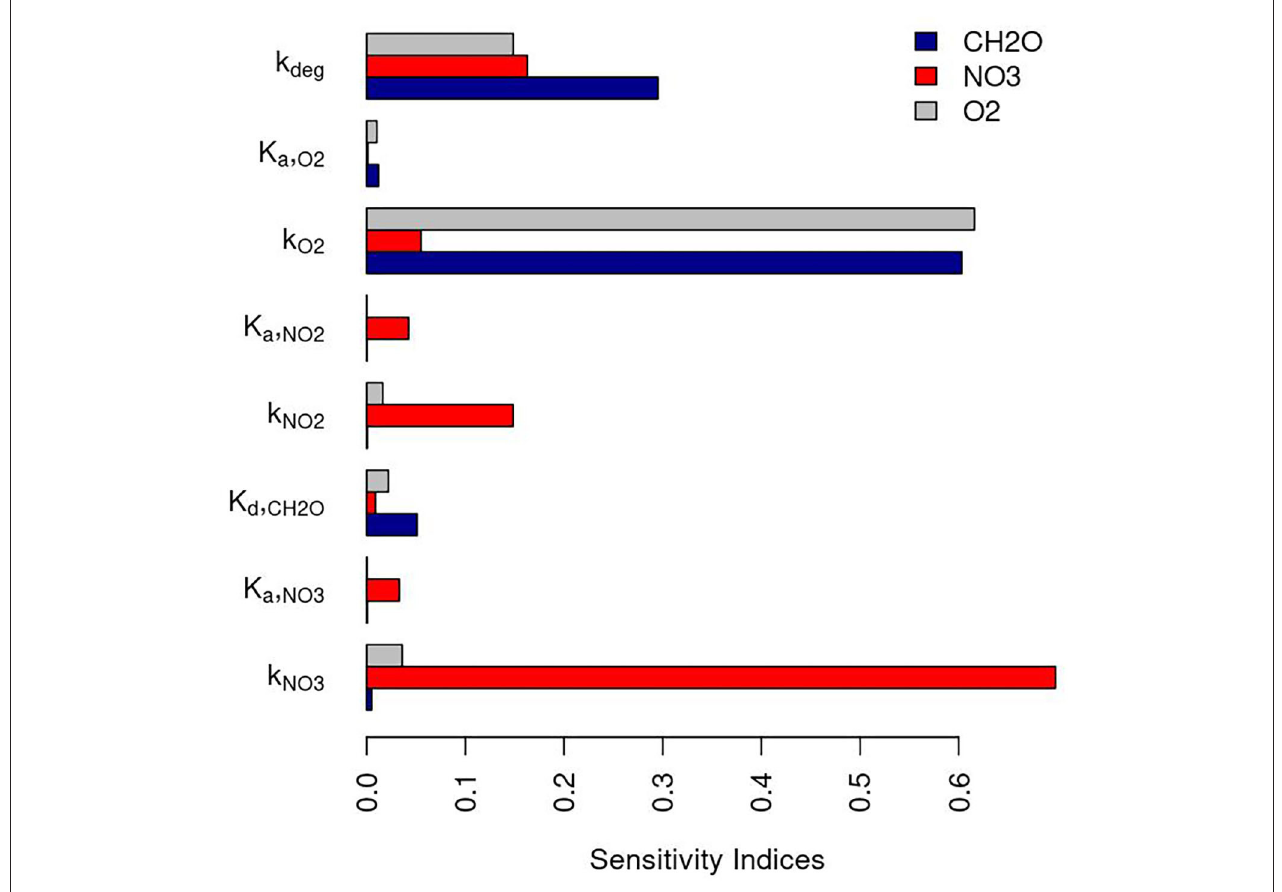
FIGURE 8 | Sensitivity indices of model parameters for TSM simulations.